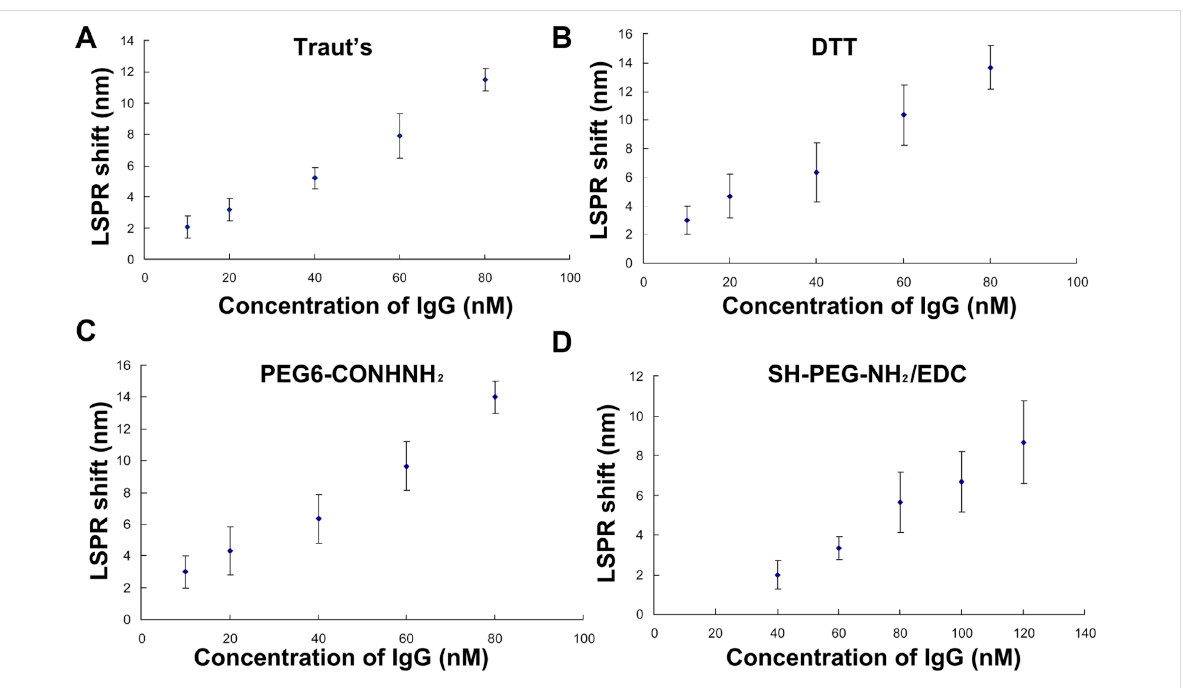
Figure 6: LSPR shifts as a function of human IgG concentrations detected by the functionalized GNR biochip with thiolated anti-IgG using (A) Traut’s reagent, (B) DTT, (C) PEG6-CONHNH 2 , and (D) SH-PEG-NH 2 combined with EDC reaction. Each data point is shown as the mean ± SD of at least three